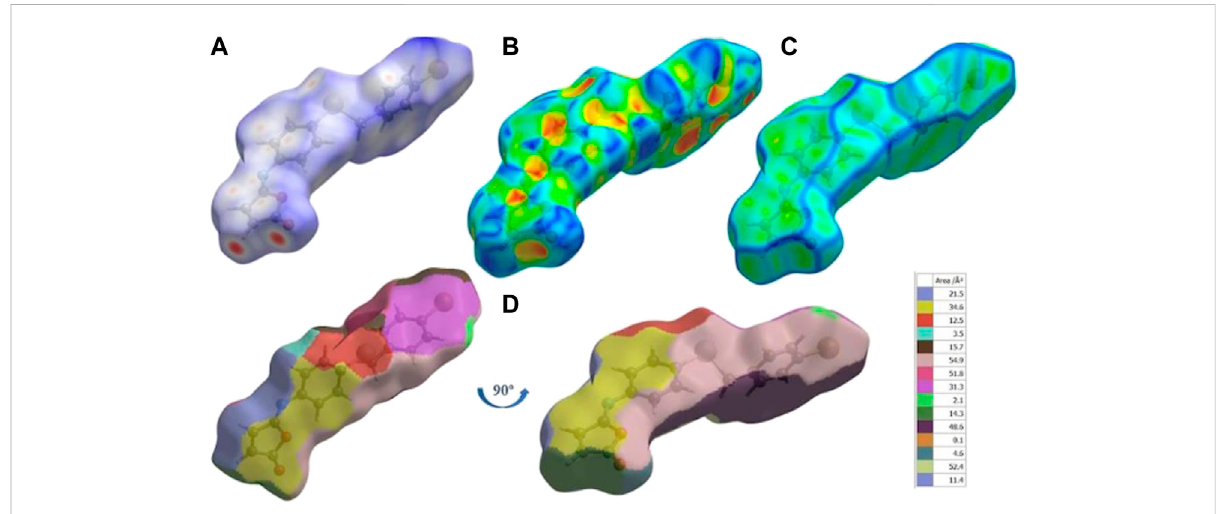
region around the phenyl rings and furan rings in curvedness (Figure 5C) indicates the presence of π -stacking interactions. The nearest molecules ’ neighbor environment is determined by the color patches (Figure 5D) on the Hirshfeld surface and their proximity to adjacent